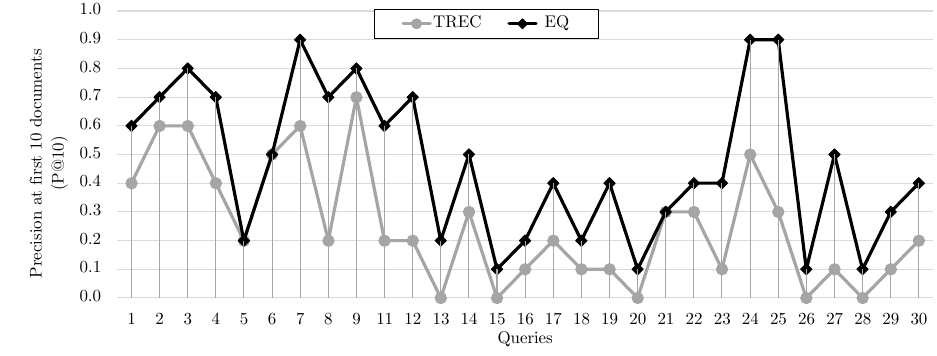
Figure 7. Comparison of the mean precision of the participants of the TREC2017 Precision Medicine Track (TREC) and that of the proposed method (EQ) in the top ten retrieved